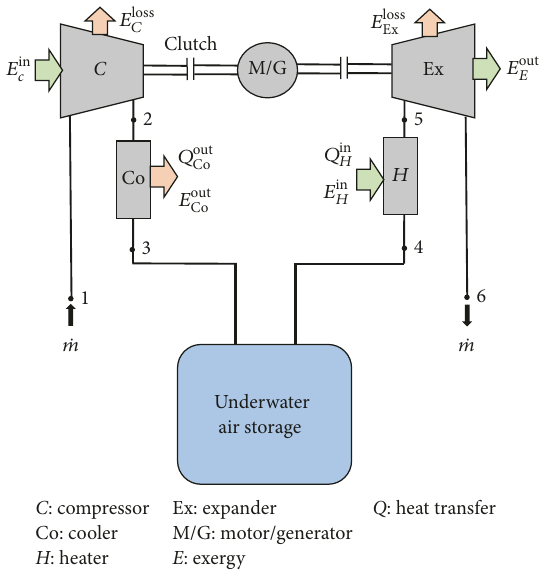
Figure 1: Schematic of diabatic OCAES.